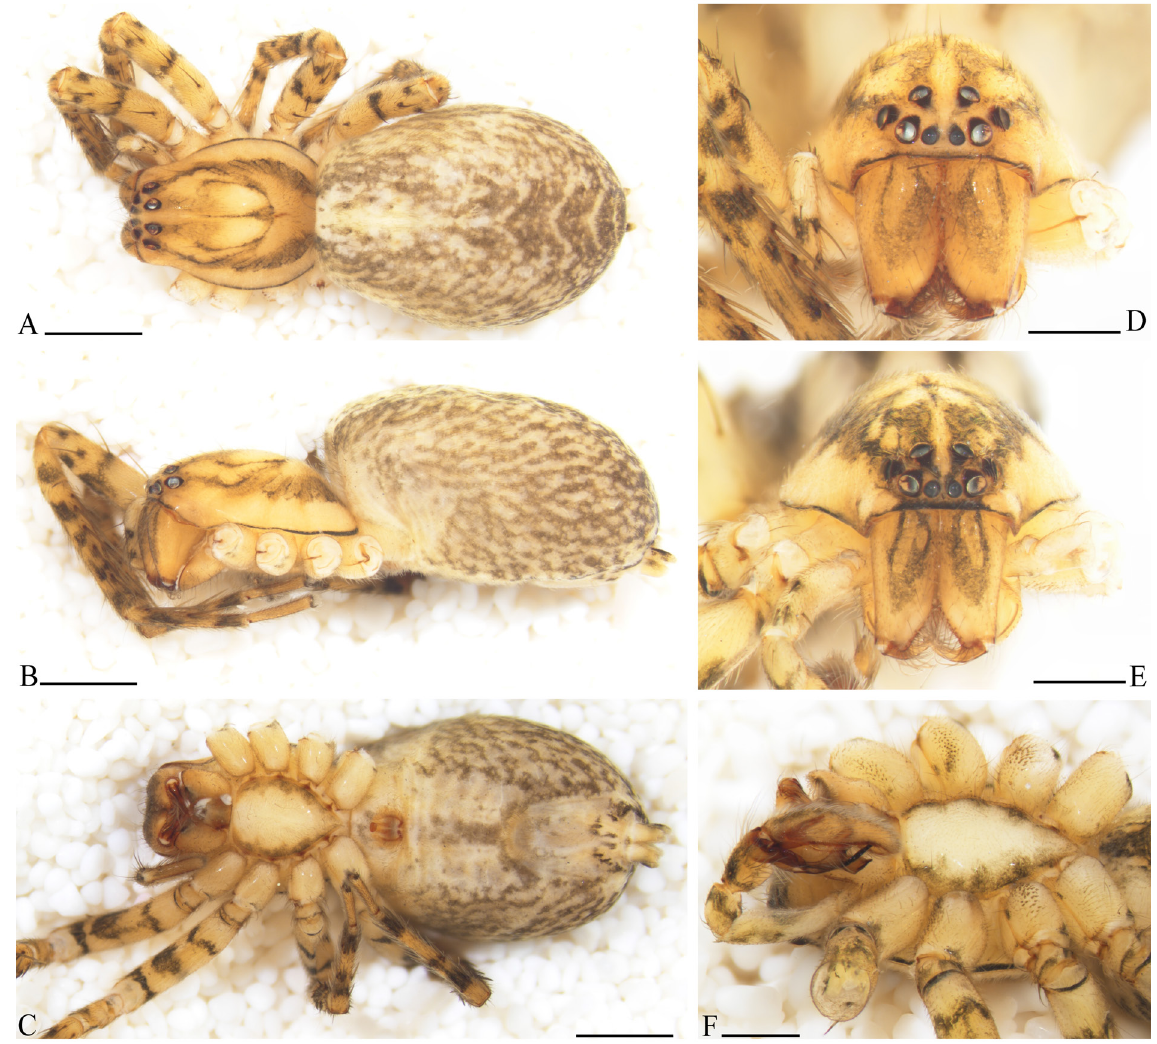
Fig. 3. Anyphaena natachae sp. nov., paratypes (CNAN-T01562). A . ♀, dorsal habitus. B . ♀, lateral habitus. C . ♀, ventral habitus. D . ♀, prosoma, anterior view. E . ♂, prosoma, anterior view. F . ♂, prosoma, oblique view. Scale bars: A–C = 1.0 mm; D–F = 0.5